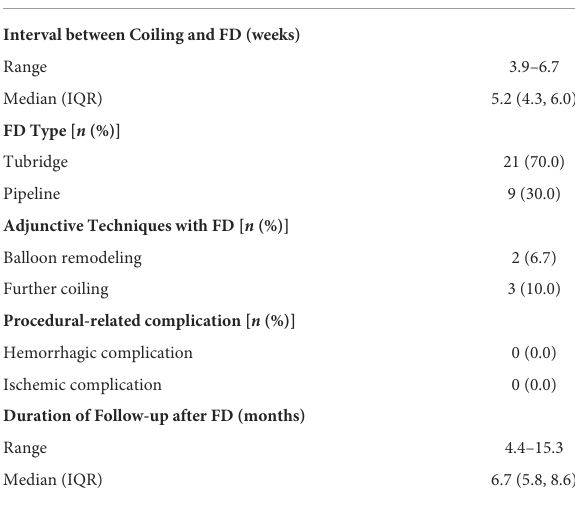
TABLE 2 Treatment characteristics of the patients.